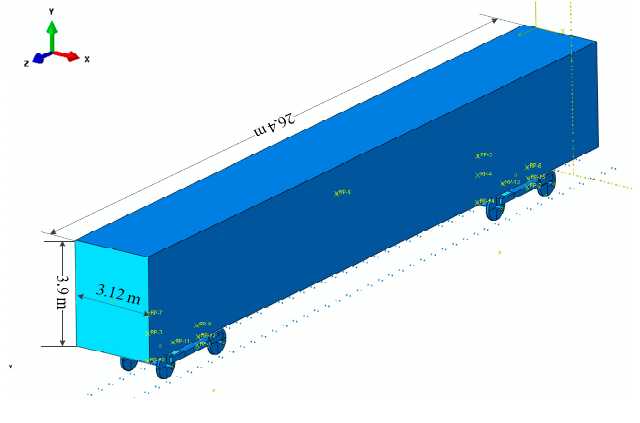
Figure 7. The vehicle model.